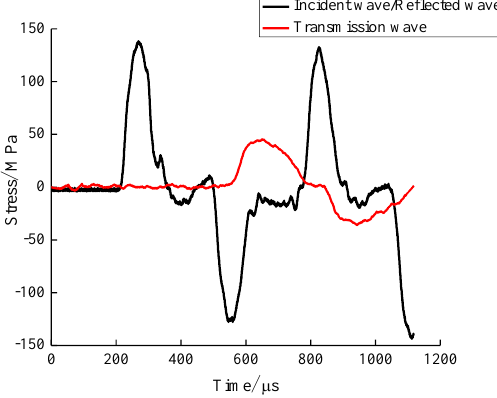
Figure 14. Experimental results ( v = 7.267 m / s).